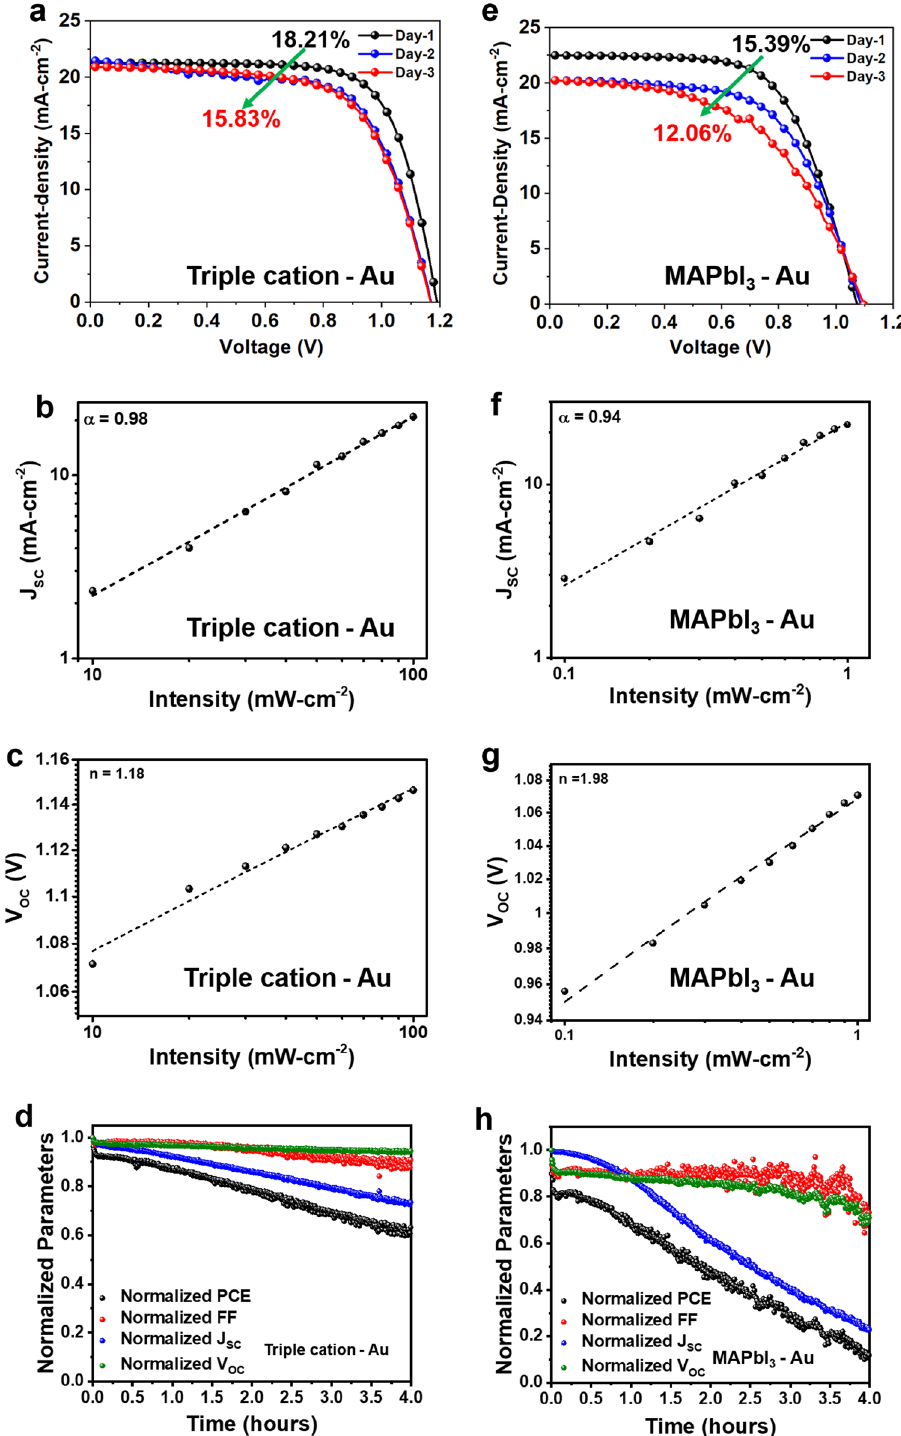
Figure 2. Device characterization analysis of triple cation and MAPbI 3 PSCs with Au electrodes. For the triple cation PSC devices, shown are the: ( a ) time-dependent PCE; ( b ) J SC – I characteristic; ( c ) V OC – I characteristic; ( d ) MPPT measurements. For the MAPbI 3 PSC devices, shown are the: ( e ) time-dependent PCE; ( f ) J SC – I characteristic; ( g ) V OC – I characteristic; ( h ) MPPT measurements. The triple-cation PSC retained ~ 60% of its initial PCE values after 4 h of testing while the MAPbI 3 PSC degraded to ~ 10% of its initial value after the same